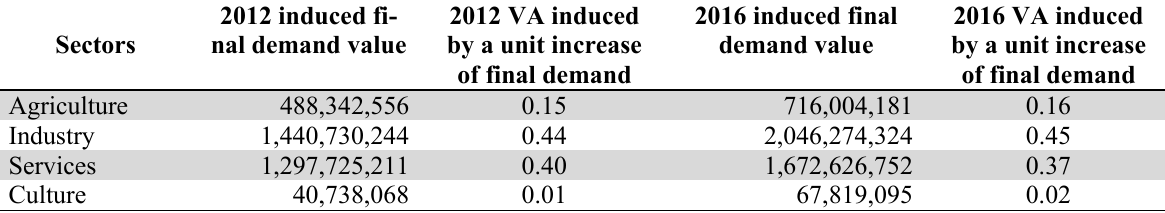
The impact of final demand of all sectors to value added of Vietnam ( Unit: million dong )